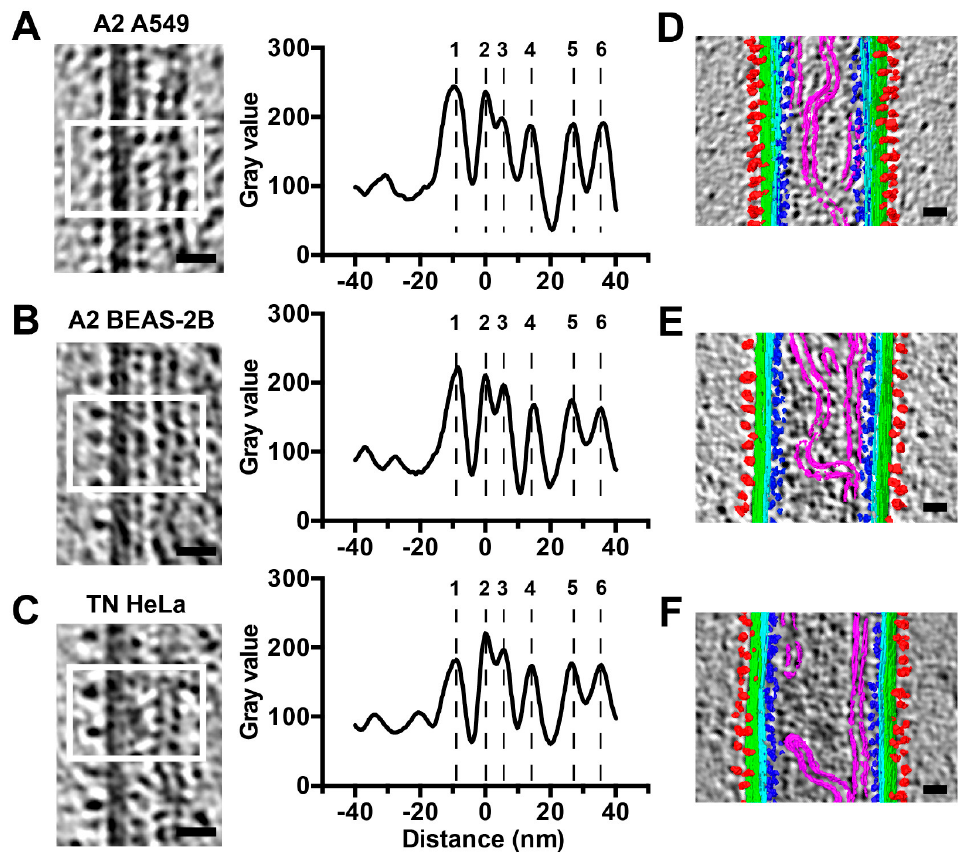
Figure 6. Structural analysis of RSV filamentous particles. ( A – C ) Representative tomographic slices and linear density profiles of RSV ultrastructure. White boxes indicate representative regions used to generate linear density plots. Linear density profiles are averaged results of multiple line profiles from several regions. ( D – F ) Segmentation illustration of the filamentous particles from indicated virus-infected cells. Note that the segmentation areas do not correspond to the regions in ( A – C ), but representative regions of samples from ( A – C ). Density peaks 1 through 6 represent: 1, Viral glycoproteins (Red); 2, Viral membrane (Green); 3, Matrix (Cyan); 4, M2-1 (Blue); 5 and 6, RNP (Magenta). Scale bars are 20